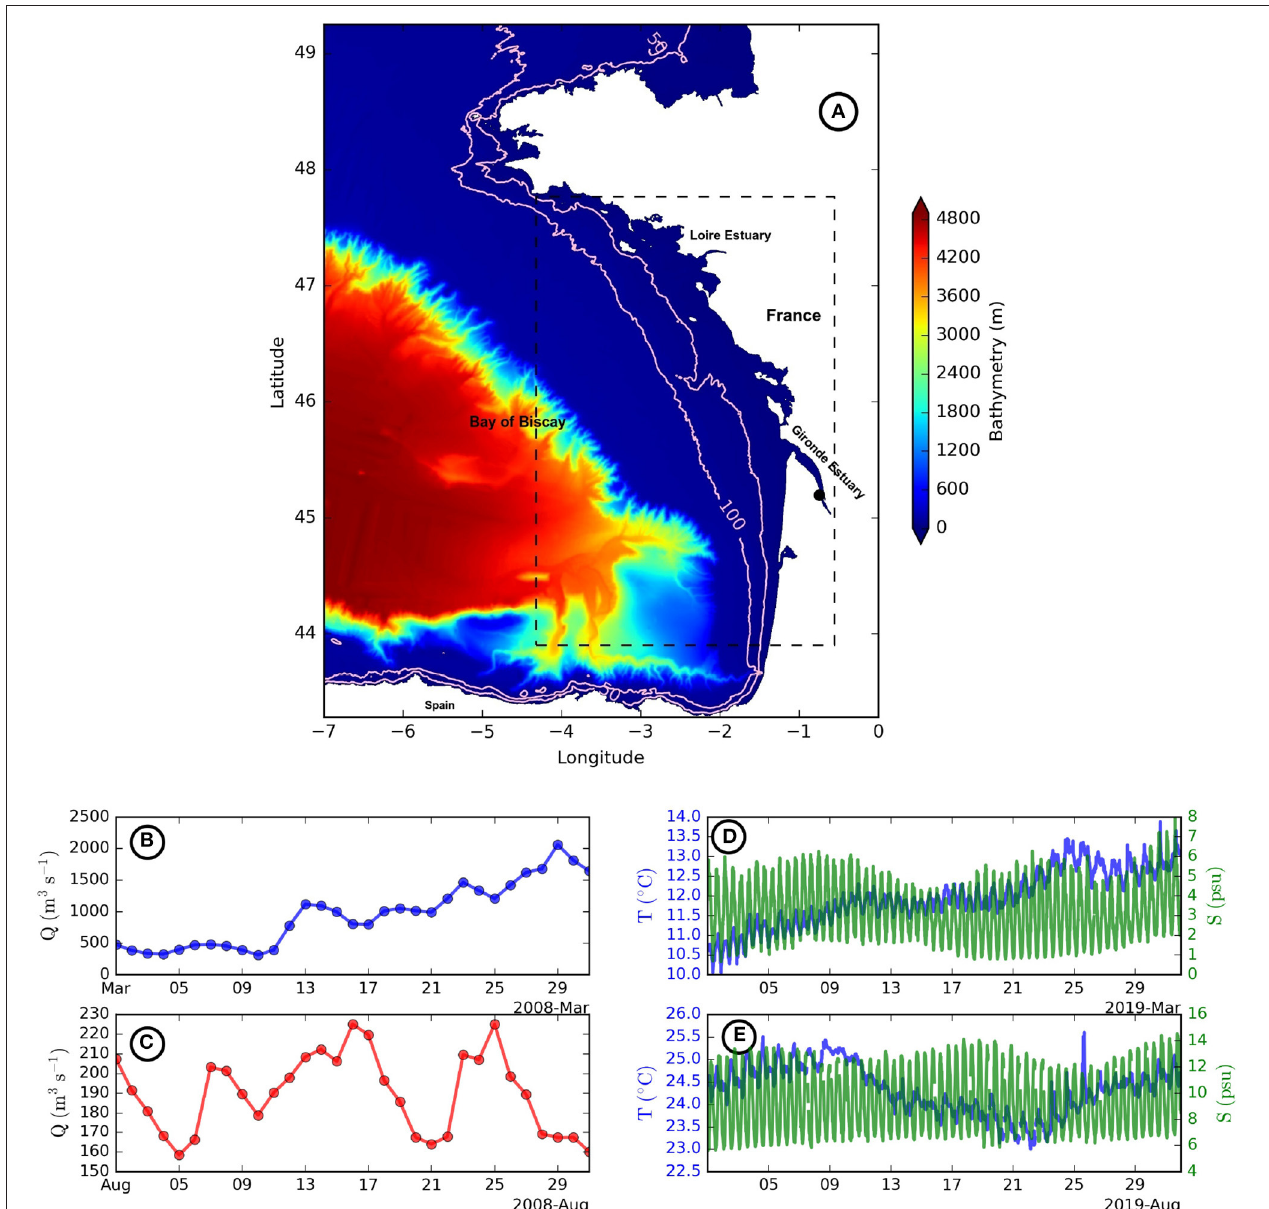
FIGURE 1 | (A) Bathymetry of the Bay of Biscay used in numerical simulations; black dashed box limits the studied region; pink solid contours for the 50 and 100 m isobaths and the black dot in the estuary shows the Pauillac station. Daily values of the Gironde river discharge in March (B) and August (C) . Time series of the temperature and salinity measured in the Gironde river estuary at the Pauillac station in March (D) and August (E)